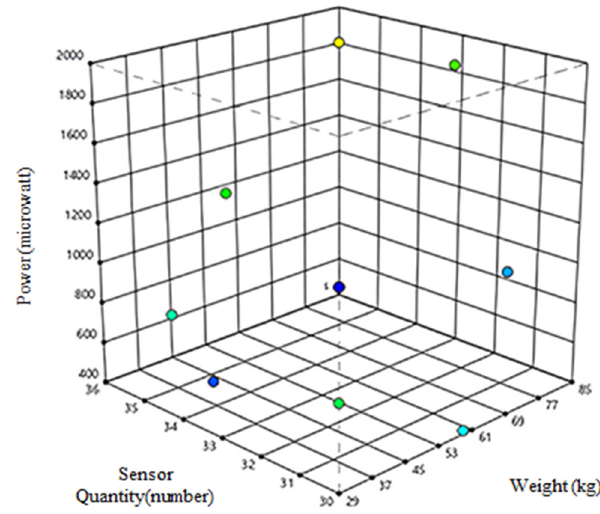
Figure 2. Correlation between power, sensor quantity, and weight.